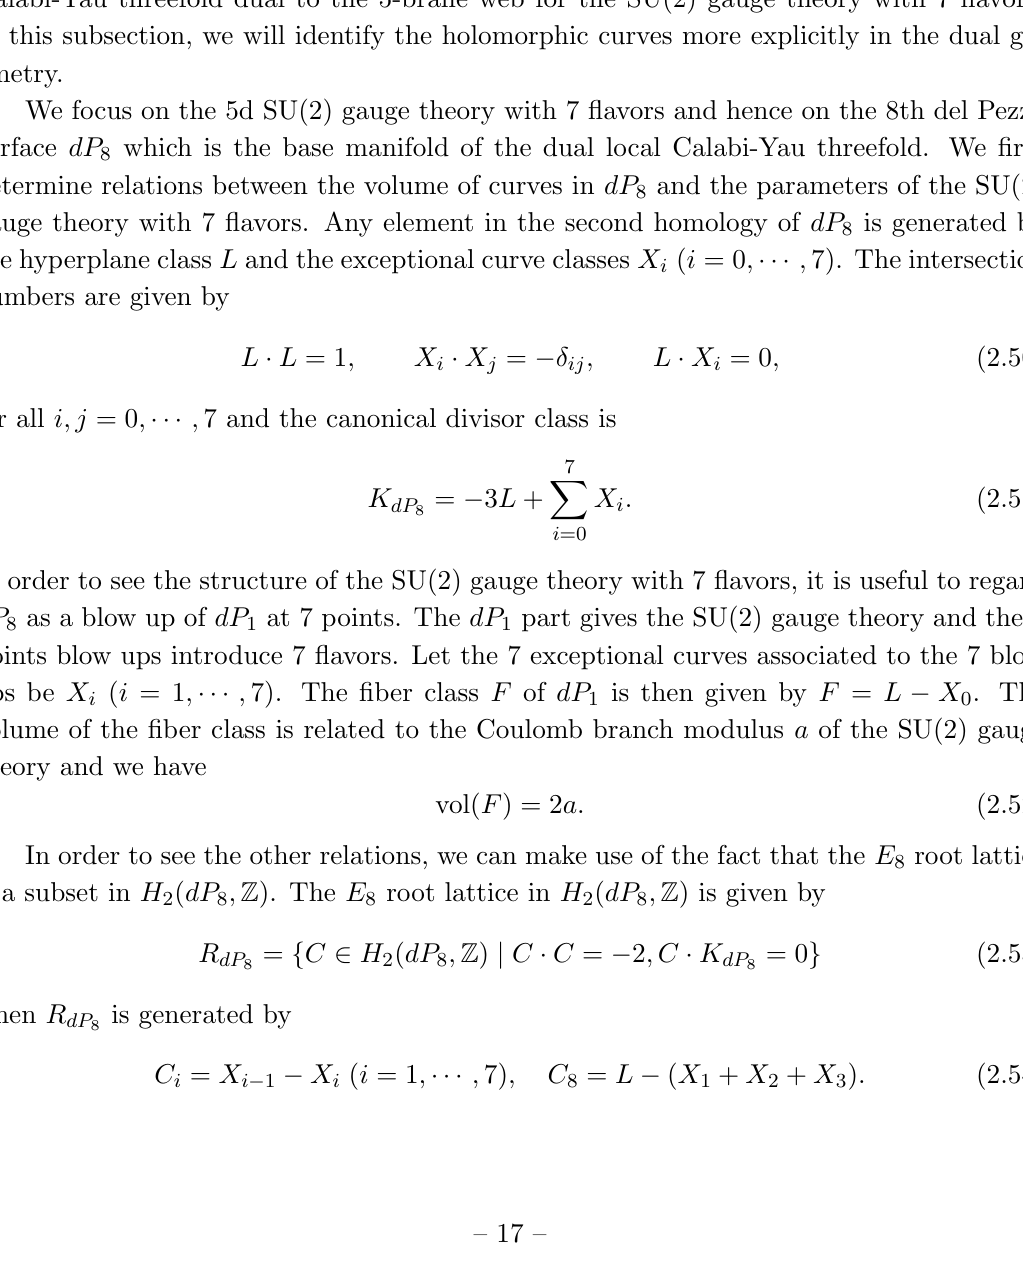
L ; j R ) = (0 ; 0), which can realize T C <